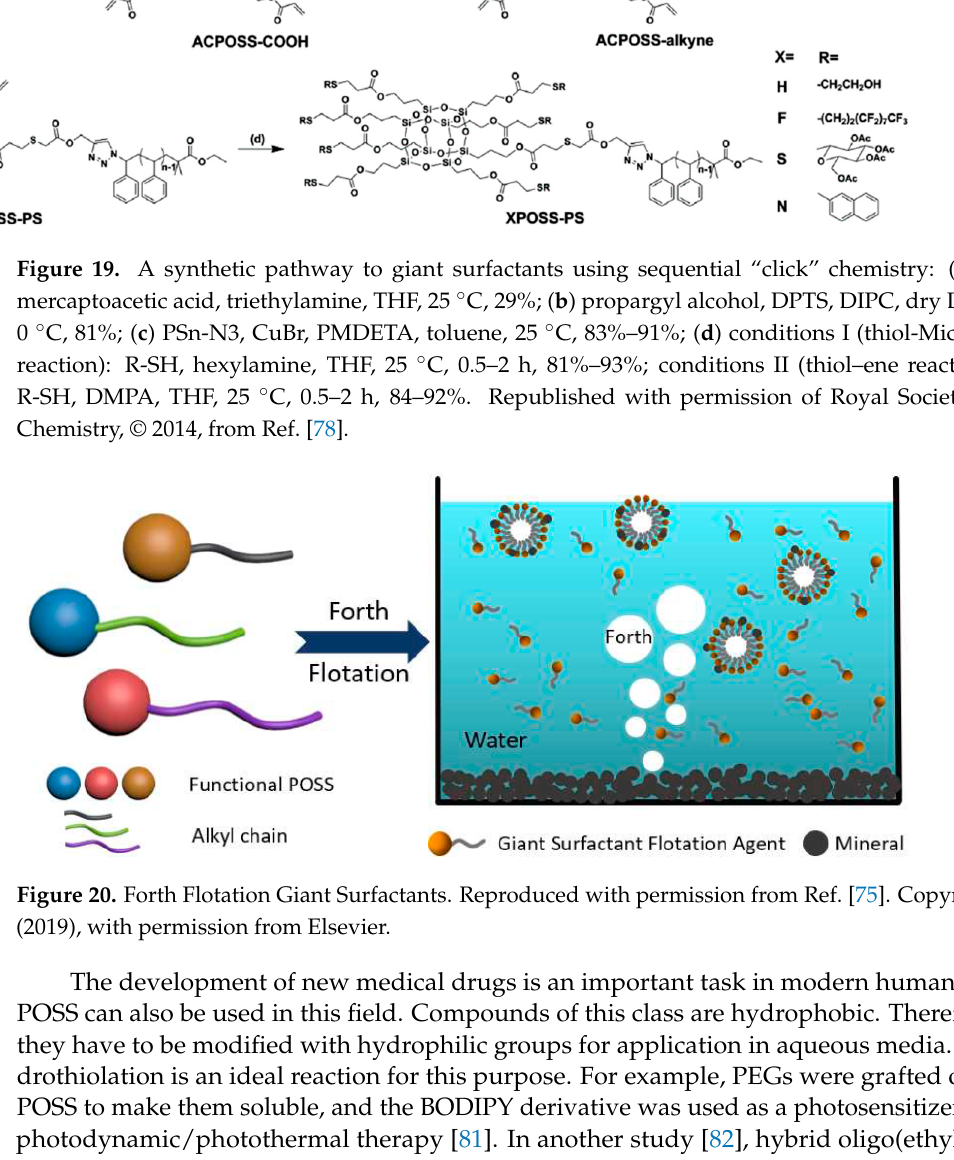
Figure 21. The synthesis of tetra-(3-mercaptopropyl)-DDSQ 3. Reprinted/adapted with permission from Ref. [92]. Shchegolikhina’s team is actively developing the synthesis of stereoregular orga- nosiloxanes, a unique class of organosilicon compounds [93–95]. These compounds are synthesized from polyhedral metallosiloxanes and cannot be obtained by the classical